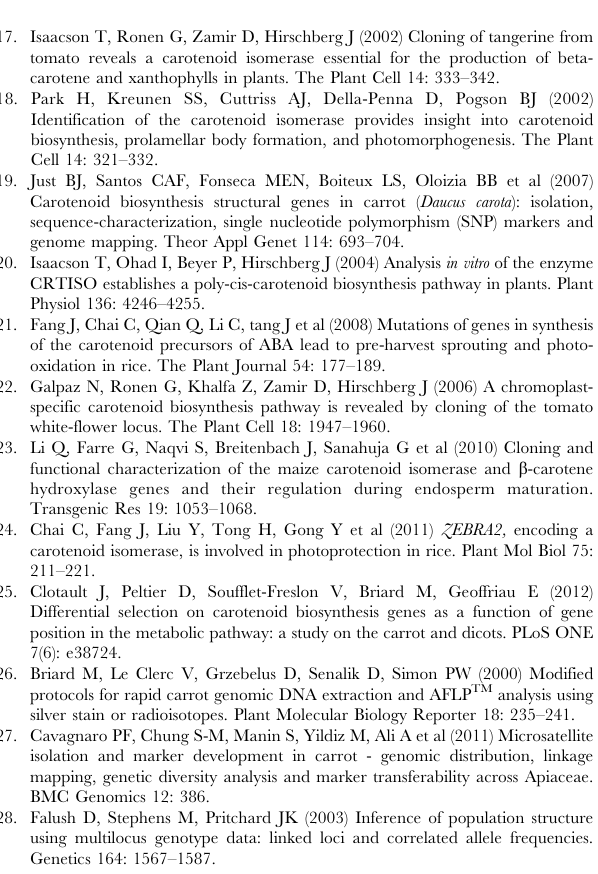
Tajima’s D with the simulated dataset obtained by the demo- graphic model. In each plot, the areas with P , 0.001, P , 0.01 and P , 0.05 are represented with red, orange and yellow backgrounds, respectively. Table S1 Characteristics of 17 carrot microsatellite markers [ 27 ]